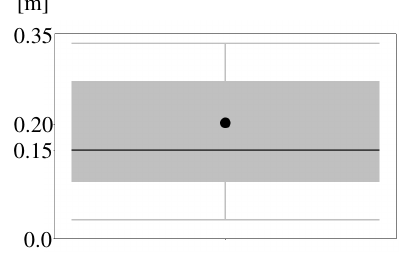
Figure 6. Matching error of the lane’s centerlines [m]. Min.: 0 . 03 m , Median: 0 . 15 m , Mean: 0 . 2 m , Max.: 0 . 34